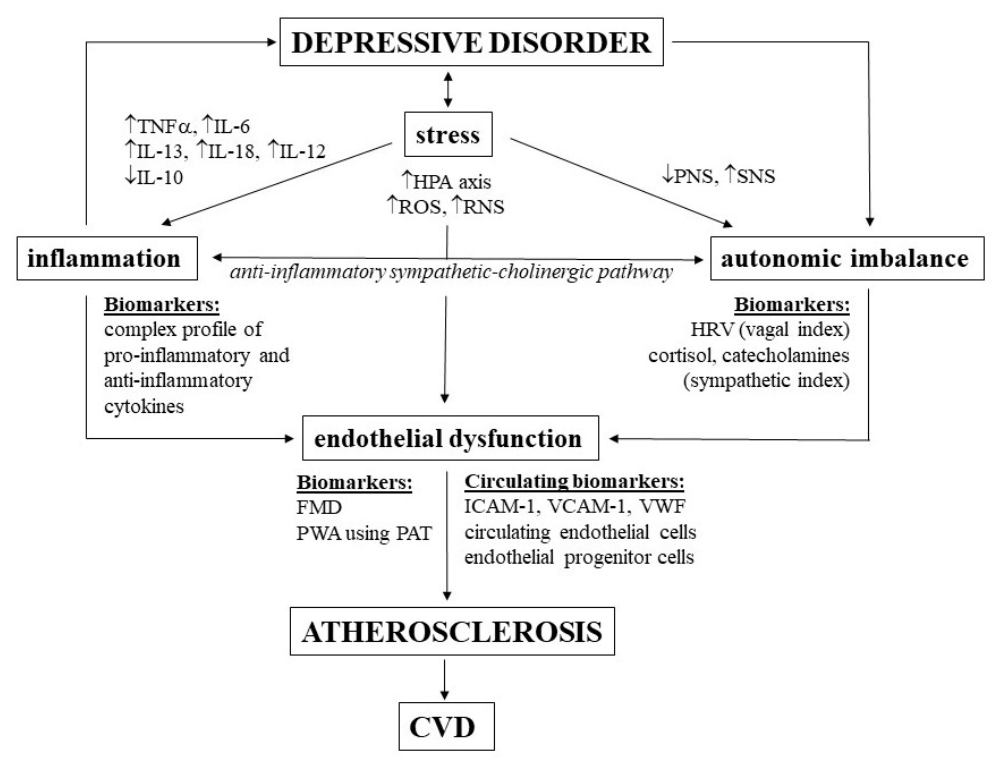
Figure 1. Pathomechanisms and biomarkers related to depression-linked increased risk of cardiovascular diseases (CVDs). TNF α , tumor necrosis factor α ; IL, interleukin; HPA, hypothalamic–pituitary–adrenal; ROS, reactive oxygen species; RNS, reactive nitrogen species; PNS, parasympathetic nervous system; SNS, sympathetic nervous system; HRV, heart rate variability; FMD, flow-mediated dilation; PWA, pulse-wave amplitude; PAT, peripheral arterial tonometry; ICAM, intercellular adhesion molecule; VCAM, vascular cell adhesion molecule; VWF, von Willebrand factor.